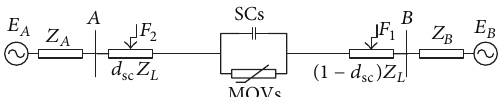
Figure 2: Single transmission line compensated with SCs and MOVs installed at midpoint.